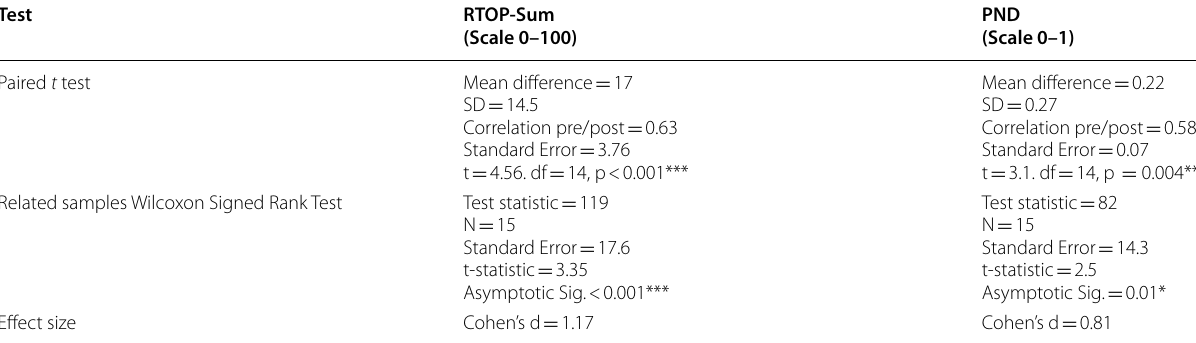
Table 8 Test statistics for the RTOP-Sum and PND measures for pre/post comparison